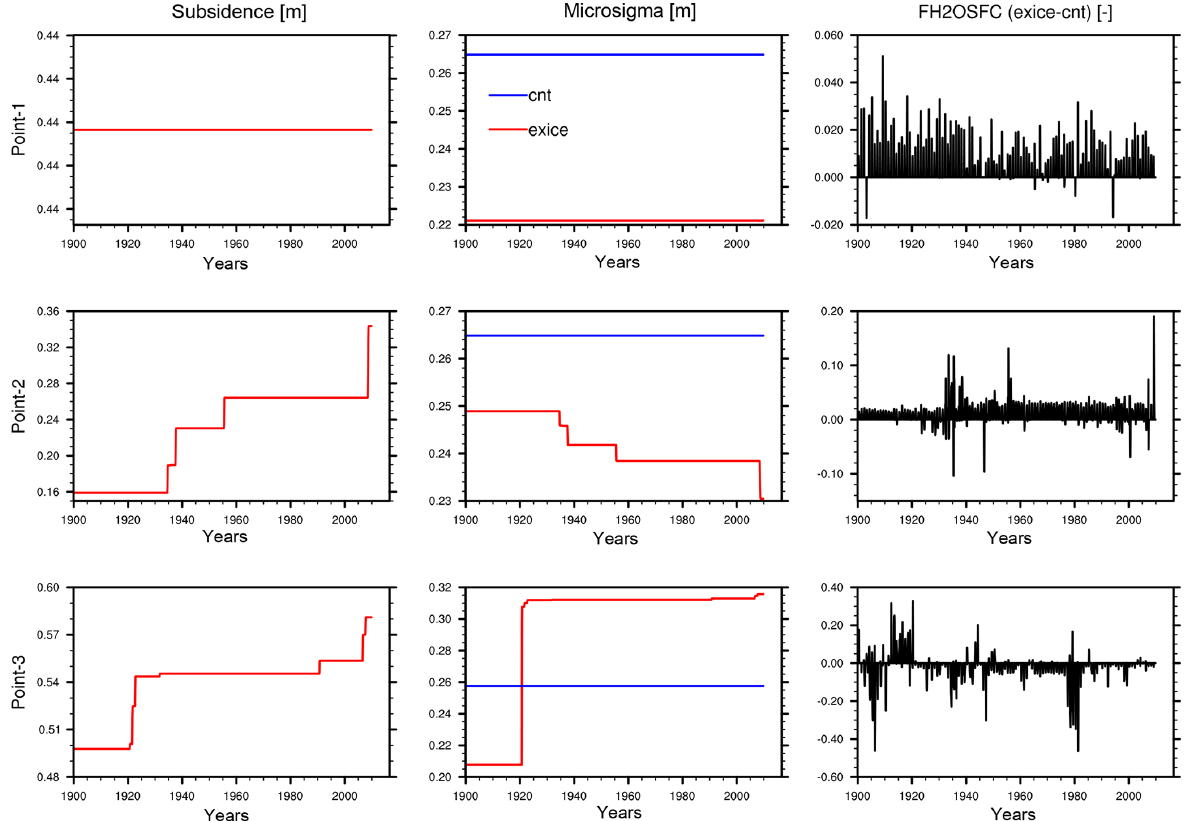
Figure 5. Time series of subsidence, σ micro , and f h2osfc variables from the Exice and Control experiments at three selected sites. Point 1: